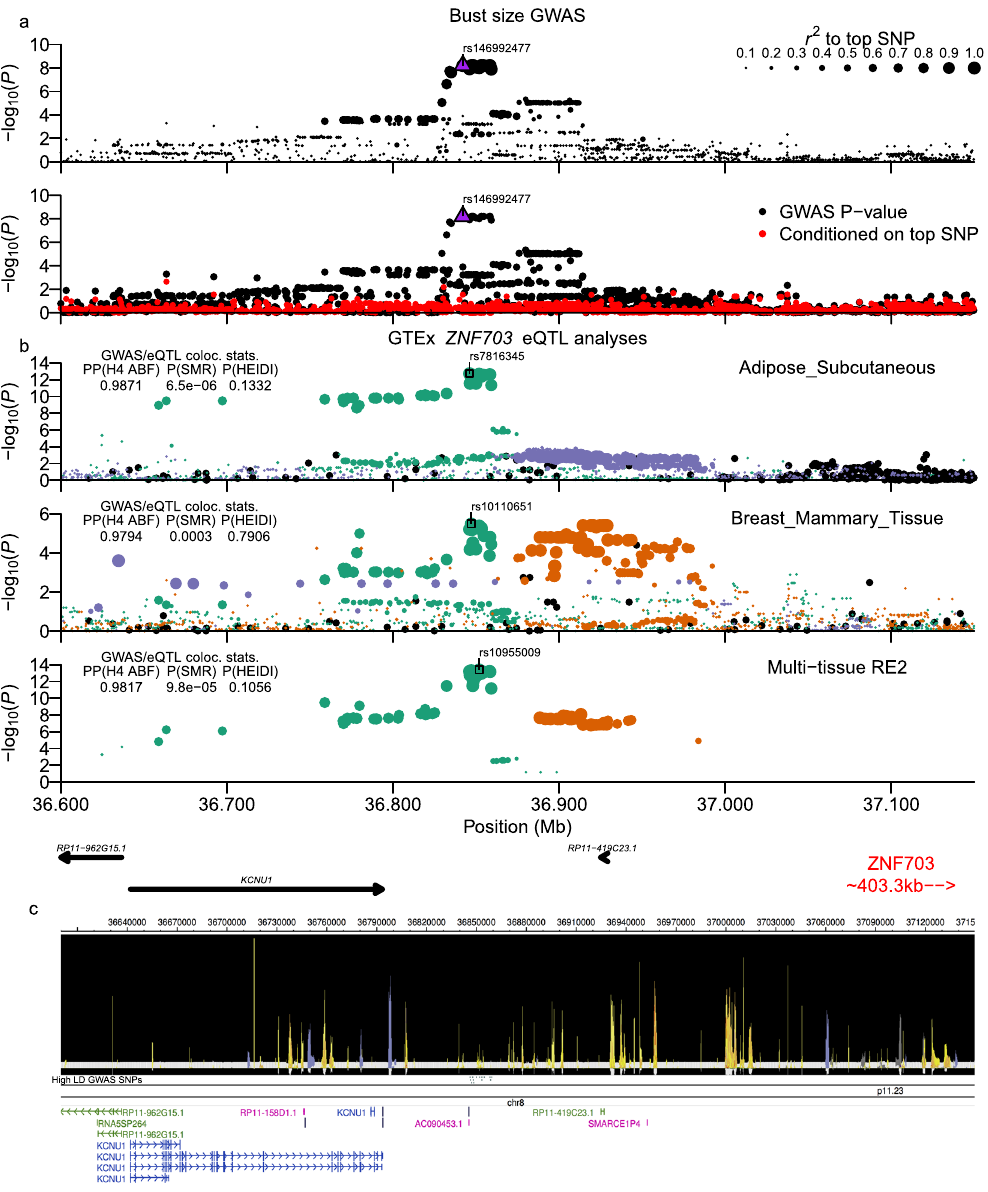
Figure 2. Bust-size chr8:36.76–36.91 Mb ( KCNU1 / ZNF703 ) locus. Plot is configured the same as Fig. 1. ( b ) Analyses of GTExPortal eQTL data for ZNF703 . Signals for ncRNA RP11-419C23.13 had strong support, but are shown in Supplementary Fig. S5. ABF colocalization analysis of multi-tissue data for both genes was run using Metasoft FE β -coefficients and standard errors as input. The gene model sub-panel highlights the two target eQTL genes in red and blue. All high LD GWAS variants shown in ( c ) also had RSS > 0.8 to top eQTL signal SNPs for each gene-tissue pair that is